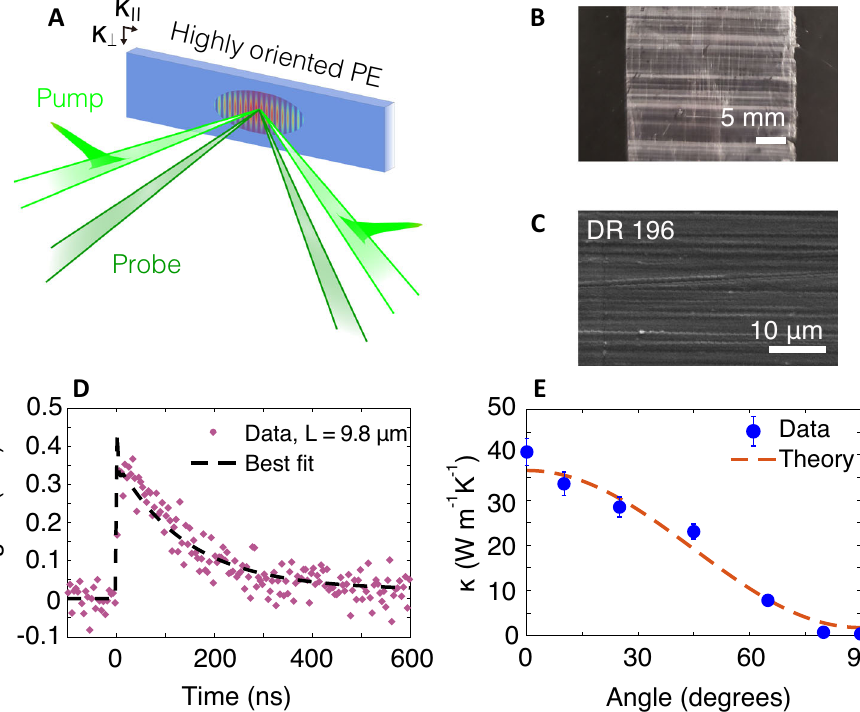
Fig. 1 In-plane thermal characterization of disentangled UHMWPE fi lms using TG. A Schematic illustration of transient grating formation and temperature pro fi le. Pump laser pulses impulsively generate a spatial grating on the sample from which probe beams diffract. B Optical image of disentangled UHMWPE fi lm (DR = 196). C SEM image of the disentangled UHMWPE fi lm. Extended fi bers over tens of μ m are visible. D Representative TG signal versus time for grating period L = 9.8 μ m at 300K. The signal is an average of 3×10 4 repetitions at a single location on the sample. The measurement was conducted at multiple locations (see Supplementary Material Section 1 for additional data). The thermal diffusivity is obtained as the time constant of the exponential decay. E Thermal conductivity versus angle between draw direction and thermal gradient de fi ned by the grating L = 9.8 μ m. The 0° (90°) indicates heat fl ow direction parallel (perpendicular) to the draw direction. The maximum thermal conductivity is around 40Wm − 1 K − 1 along the chain, while the perpendicular value is comparable to that of unoriented